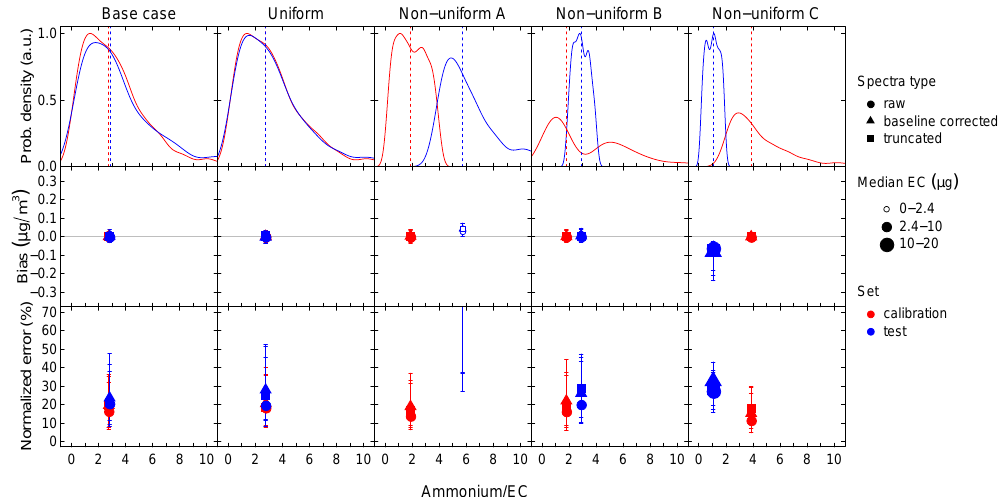
Figure 5. The probability distribution of ammonium/EC and bias and normalized error (with the interquartile range shown by error bars) in the calibration (red) and test (blue) sets for five hybrid calibration cases: the Base case, the Uniform ammonium/EC case and three Nonuniform ammonium/EC cases. Vertical lines on the probability distributions are the color-coded median of the ammonium/EC